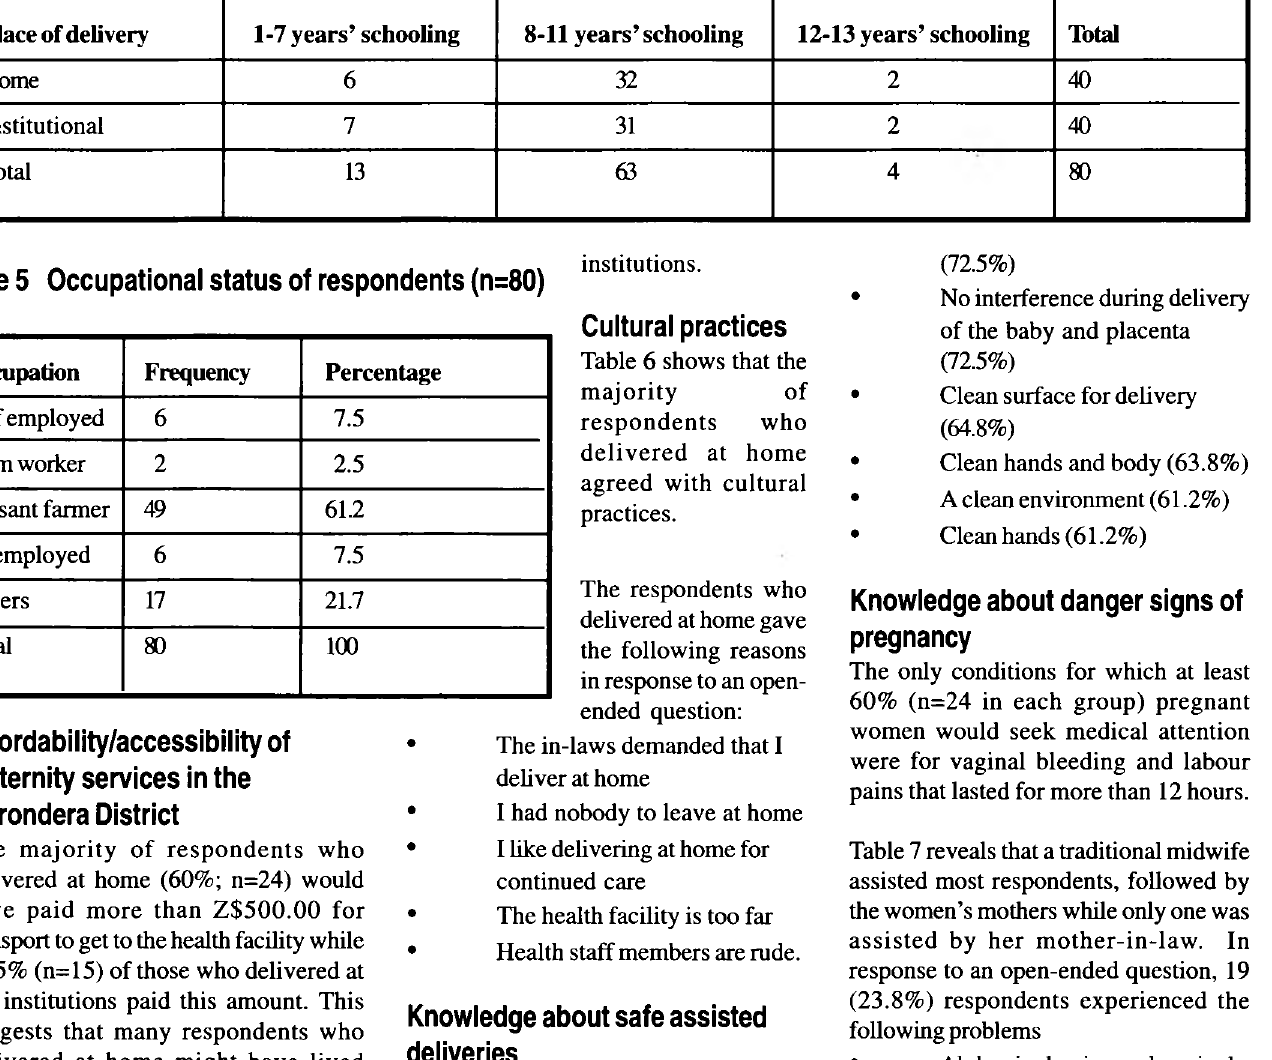
Table 6 Cultural practice versus place of delivery Cultural